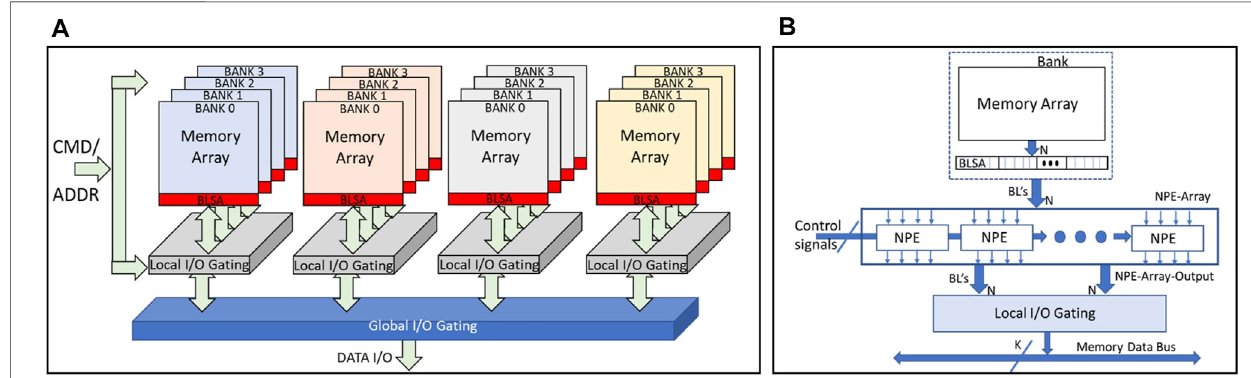
FIGURE 8 | (A) DRAM bank organization and (B) Integration of the NPE with a DRAM bank.